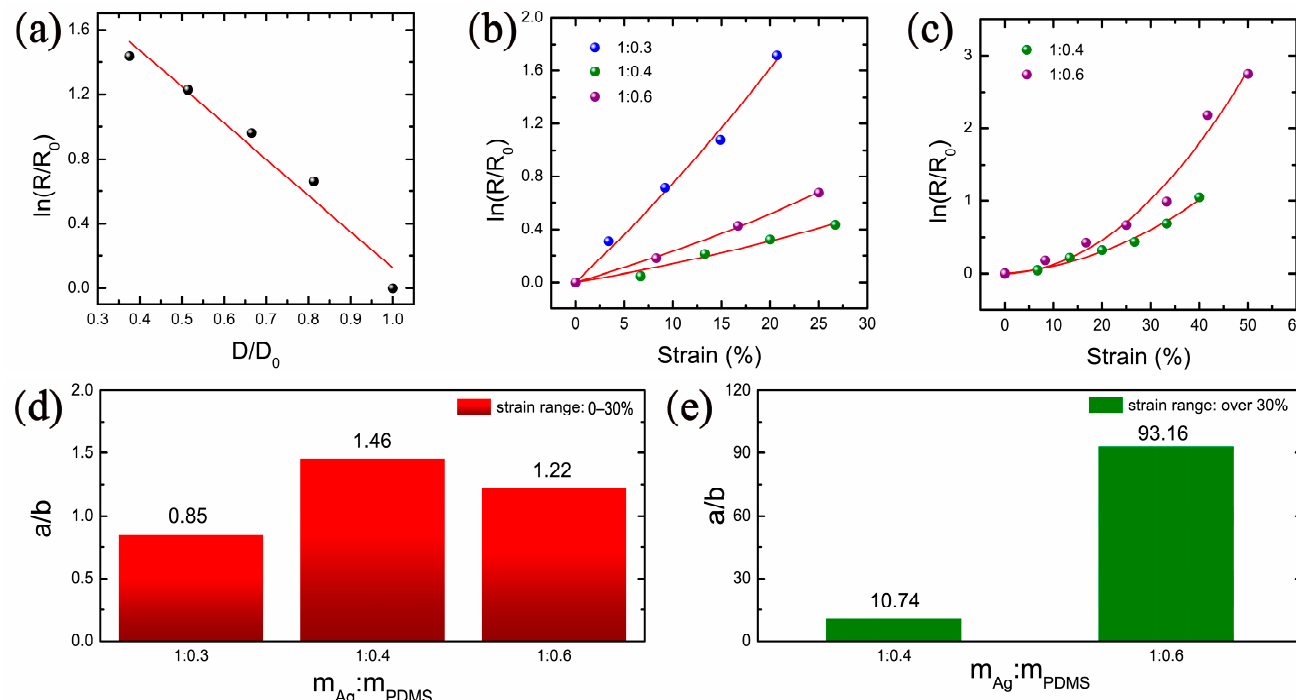
Figure 7. Conductive mechanism analysis of the PDMS-Ag electrodes. ( a ) Contact point theoretical fitting. Tunneling effect theoretical fitting under ( b ) small and ( c ) large strains. Statistics of the proportional coefficients a/b of the tunneling theoretical equation under ( d ) small strain and ( e ) large strain.